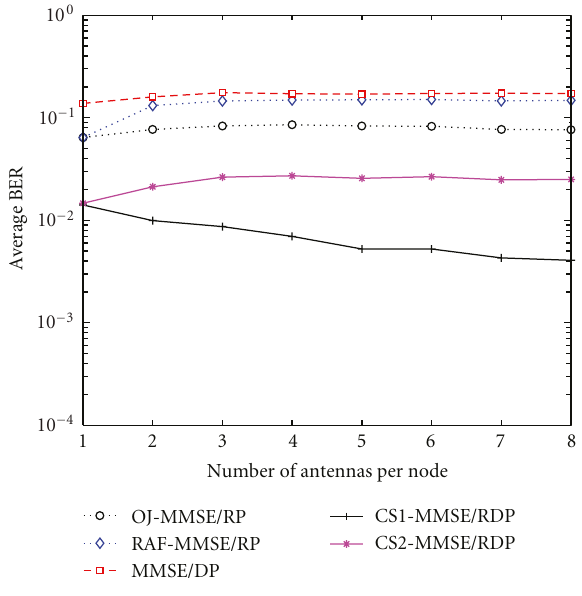
Figure 10: BER versus pathloss of direct path in uplink (SNR 1 = SNR2 =